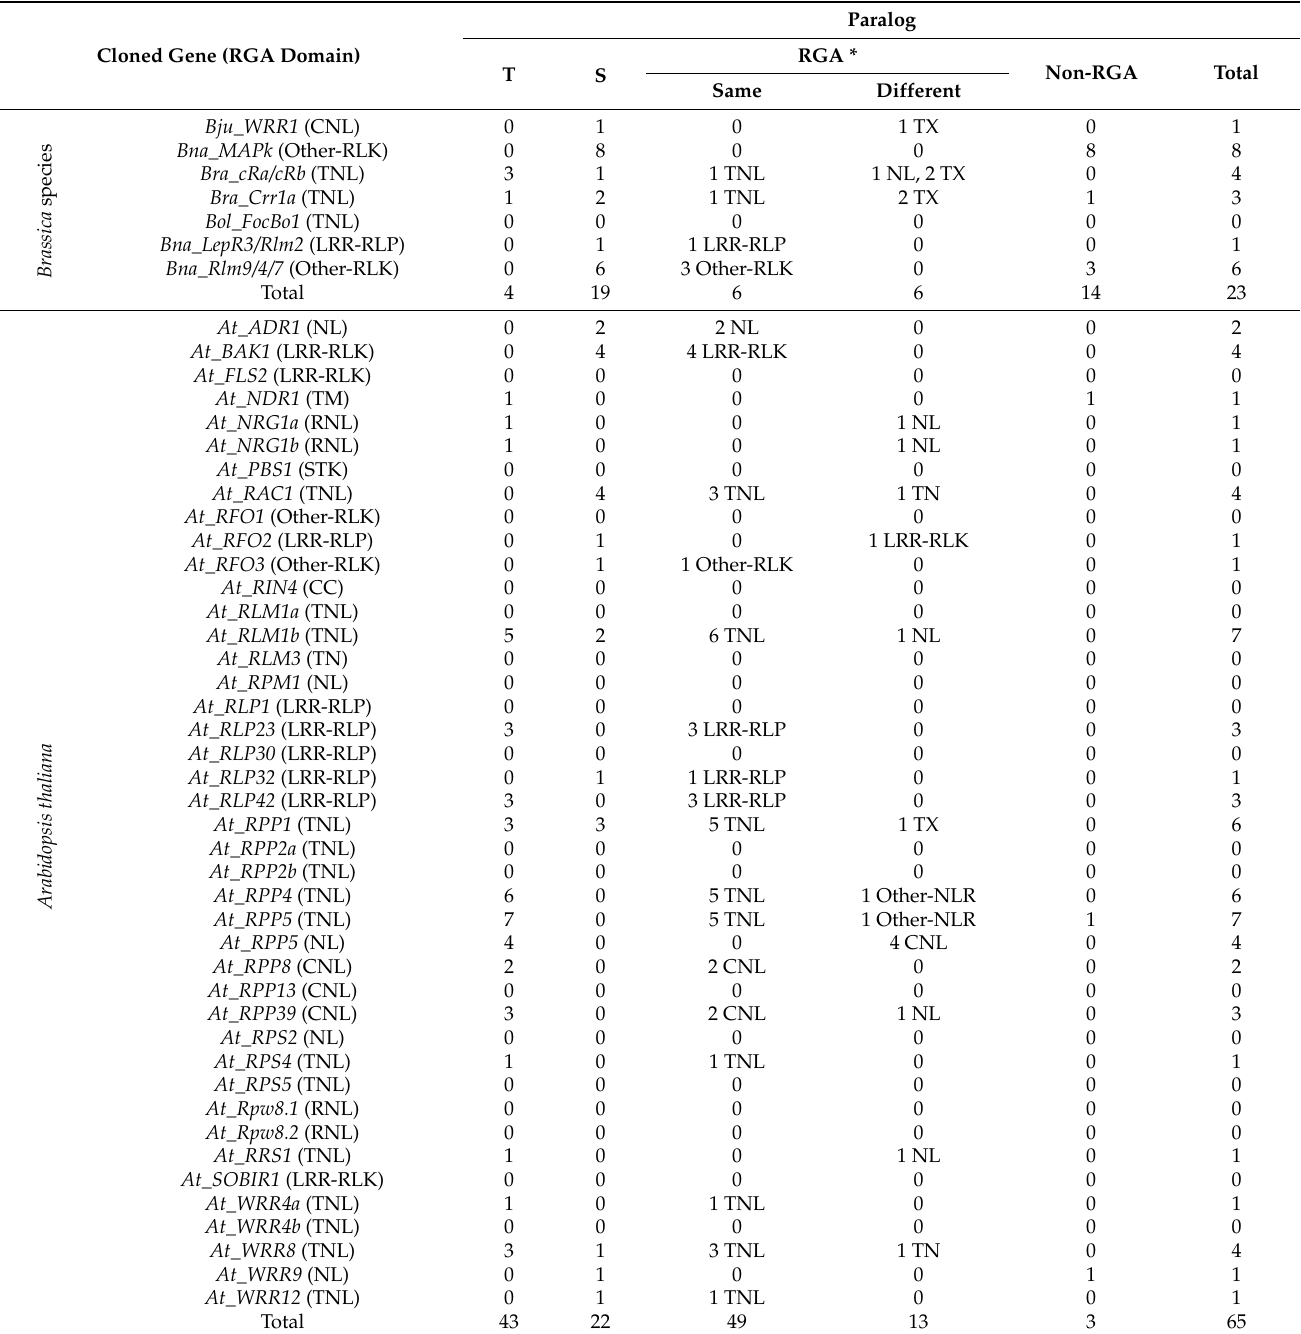
Table 3. Cloned genes in Brassica crops and Arabidopsis thaliana and their corresponding paralogs (cloned disease R gene homolog